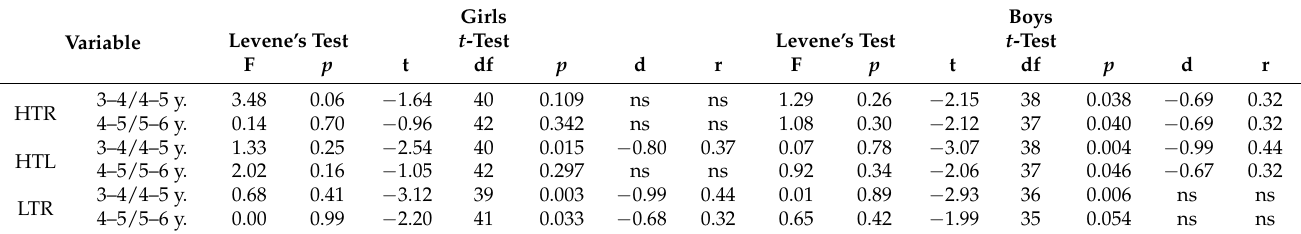
Table 4. Age differences in static and dynamic tests of preschool